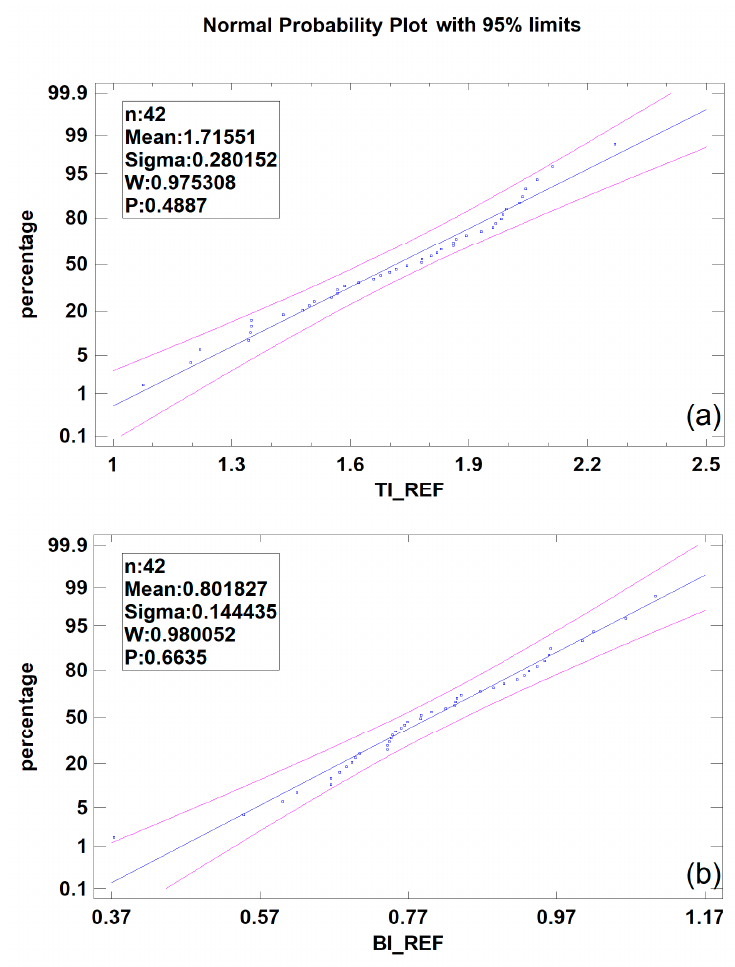
Figure 2. Distribution of Texture Index (TI)—( a ) and Bone Index (BI)—( b ). Note: n, number of cases; W, Shapiro–Wilk test result; P, statistical